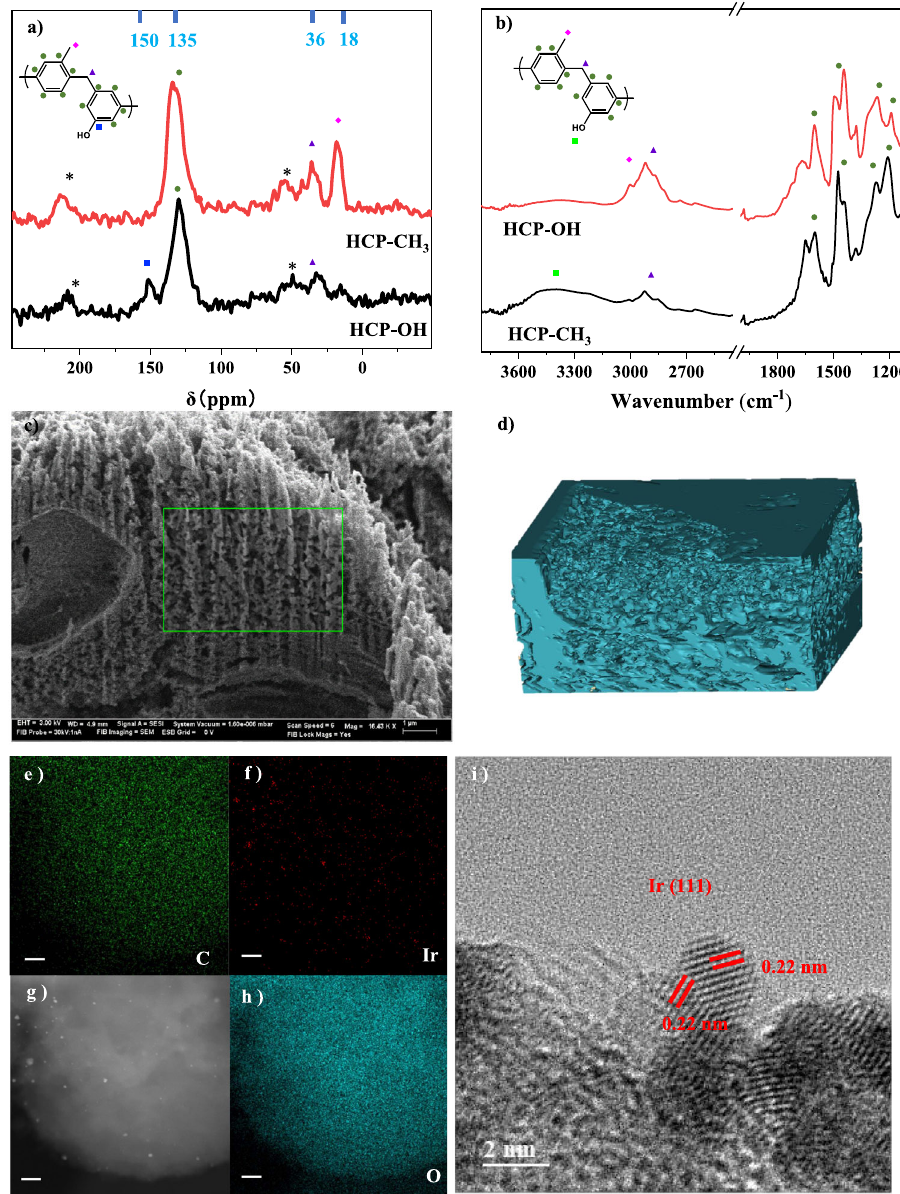
Fig. 2 | Catalyst structure and composition. a Solid-state 13 C CP/MAS NMR of HCP-OHandHCP-CH 3 .Asterisksdenotespinningsidebands. b FT-IRoftheHCP-OH andHCP-CH 3 . c SEMimagesofHCP-OH.ThegreensquareistheFIBreconstruction